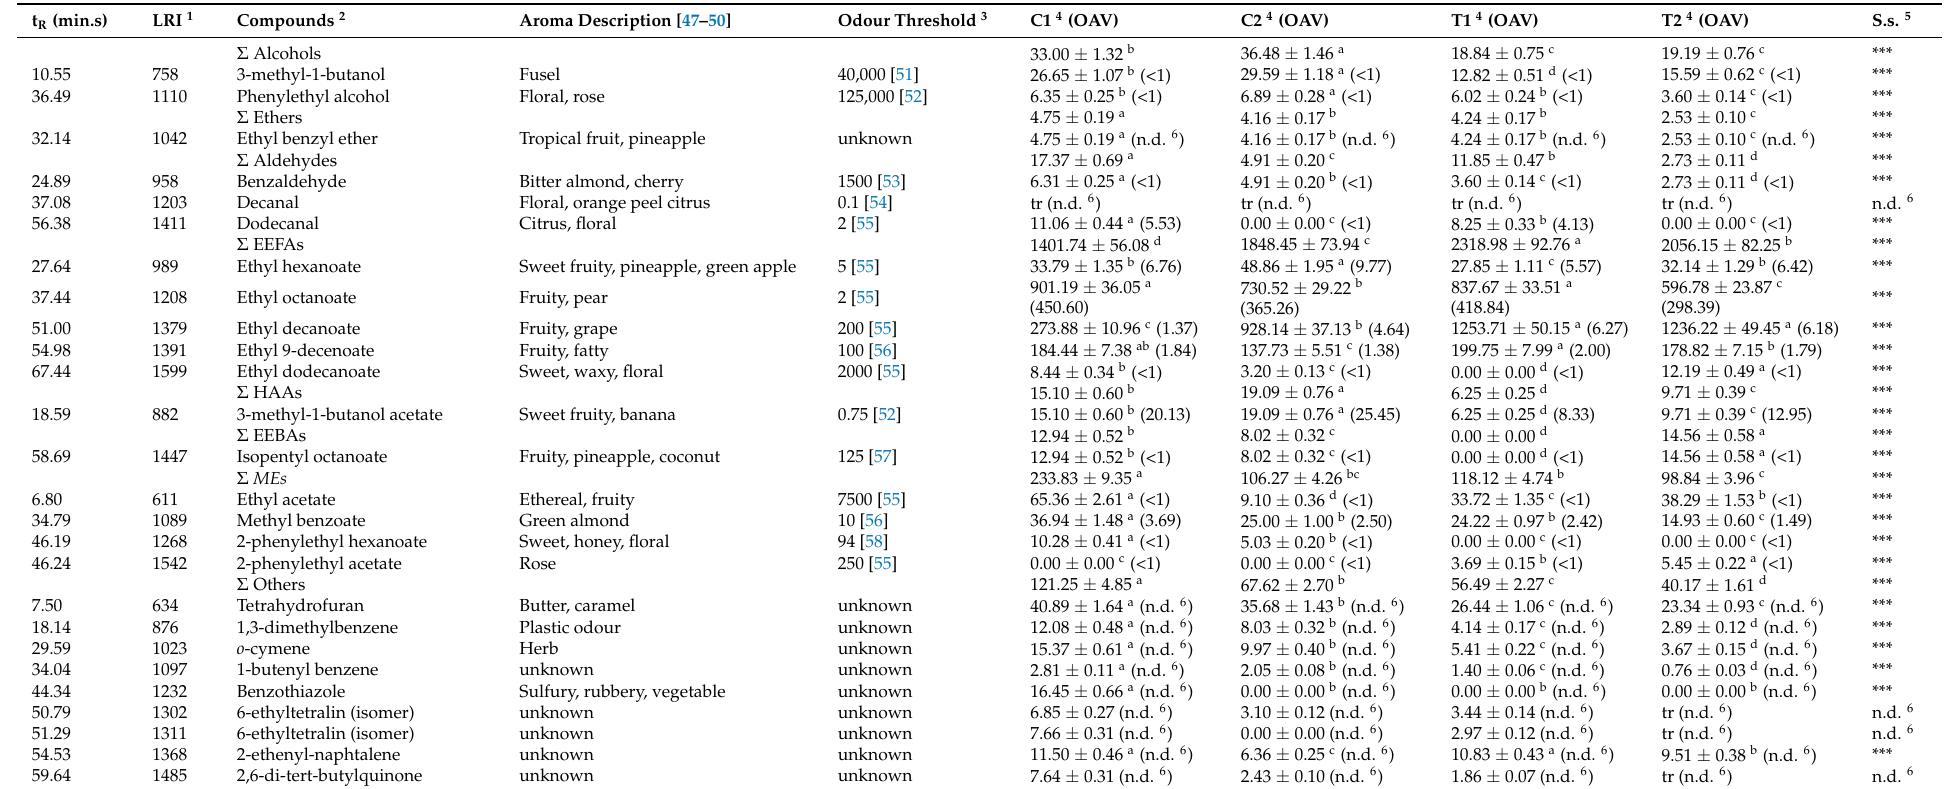
Table 2. Volatile organic compounds detected in the four Catarratto wines (all values in